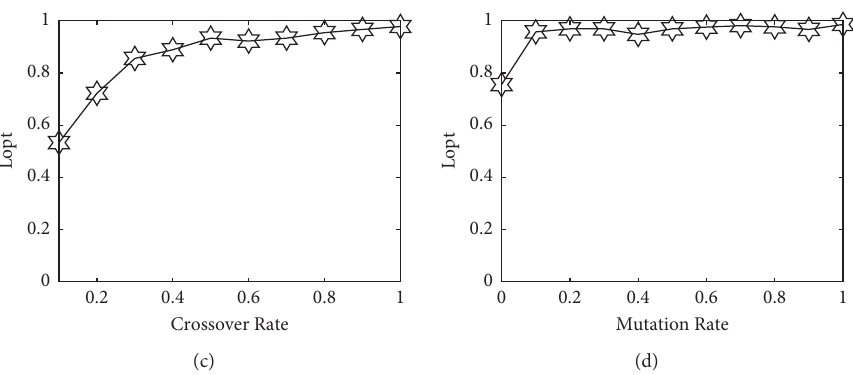
Figure 7: The Lopt comparison results of different parameters: (a) population generation; (b) population size; (c) crossover rate; (d) mutation